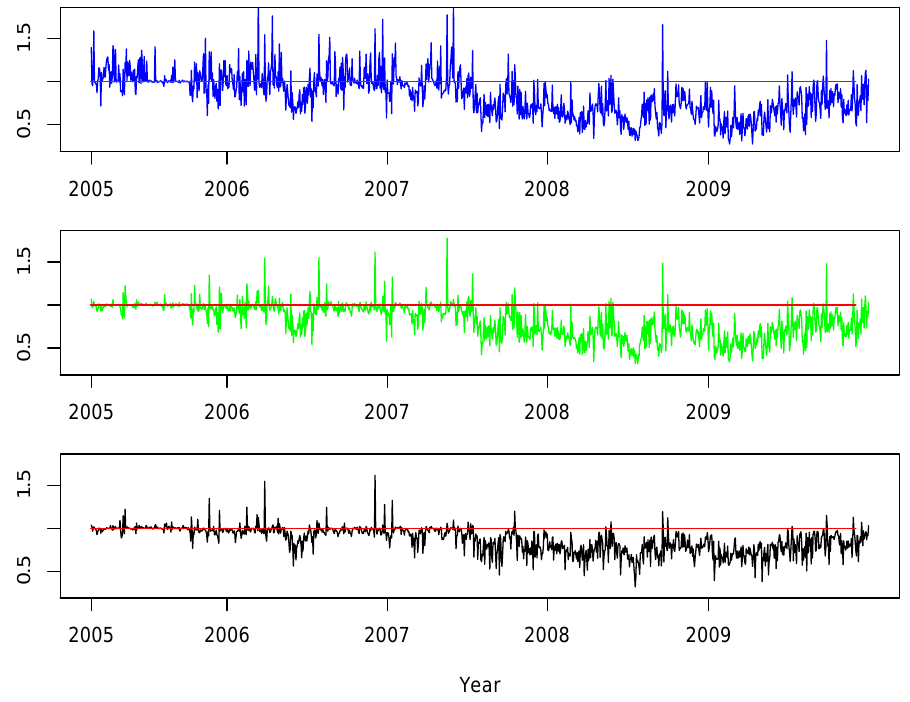
( (cid:101) w t , (cid:101) L t ) / σ 2 ew Figure 10. Ratios σ 2 for the HAR, AR(5), and AR(1) models, from above to below. t , t Note: the red lines correspond to a ratio of one, indicating equal